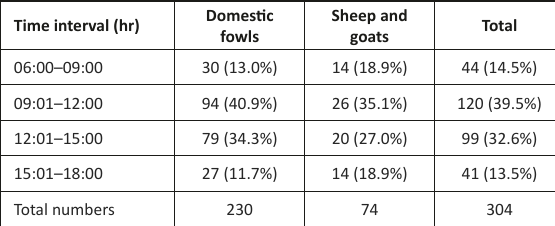
Domestic Sheep and fowls goats